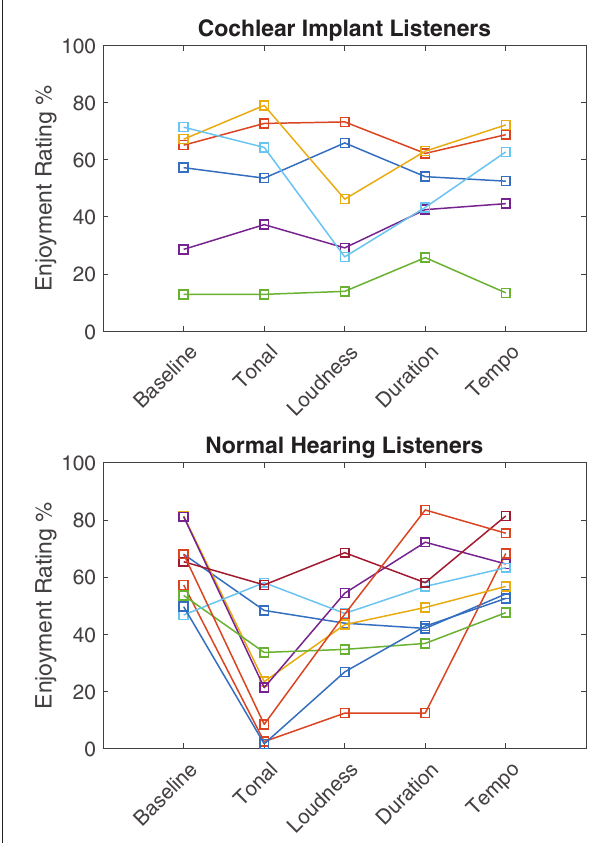
FIGURE 8 | Average enjoyment ratings for each condition of 6 CIL (in black) and 9 NHL (in blue). Horizontal lines and asterisks indicate significant differences ( p < 0.01). See details in Figure 7 .